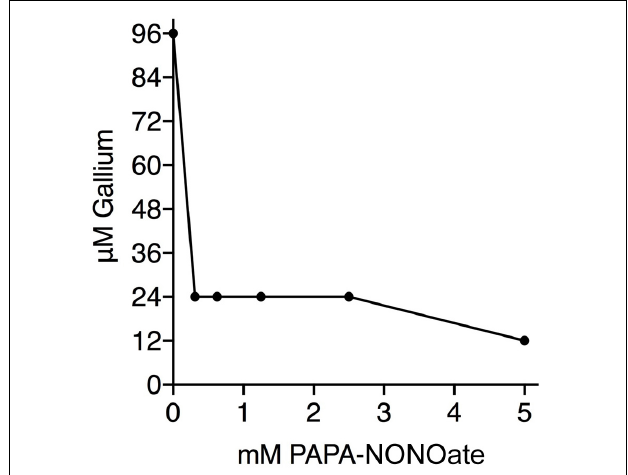
FIGURE 2 | Nitric Oxide and Ga 3 + have synergistic antibacterial activity. Isobologram shows the results of aerobic checkerboard assays using PA14. The MIC for PAPA-NONOate was > 5 mM. Three replicates done.